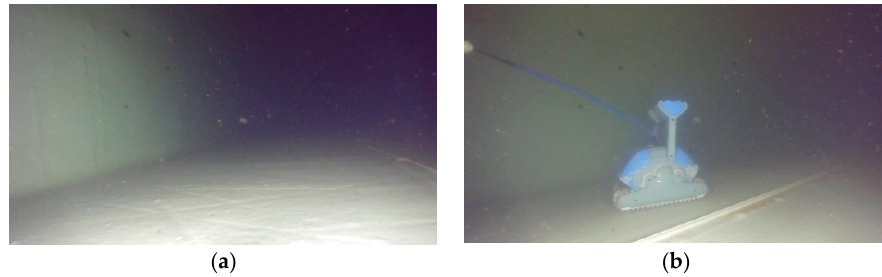
Figure 2. Images taken with the vision system of the Kai submarine in the hydrodynamic test channel: ( a ) Bottom of the ship model basin; ( b ) Process of cleaning up the ship model